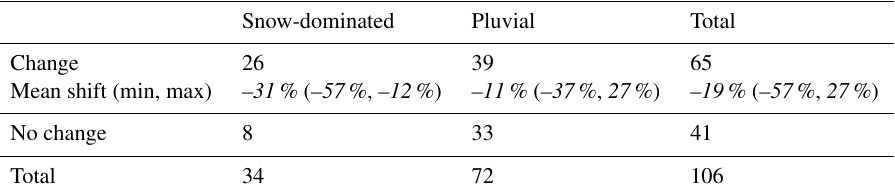
Figure 6. Box plots of 10-year mean precipitation (a) , observed runoff (b) , and simulated ET from HBV (c) for the period April 1970 to March 2010 (i.e. excluding the MD). The red marks correspond to the decadal means during the MD (April 2010 to March 2020). Please note the log scale of the y axes in (a) and (b) . Table 2. Number of catchments with a significant shift and no shift in P–R relationships during the MD. The shift magnitude in catchments with change is given in